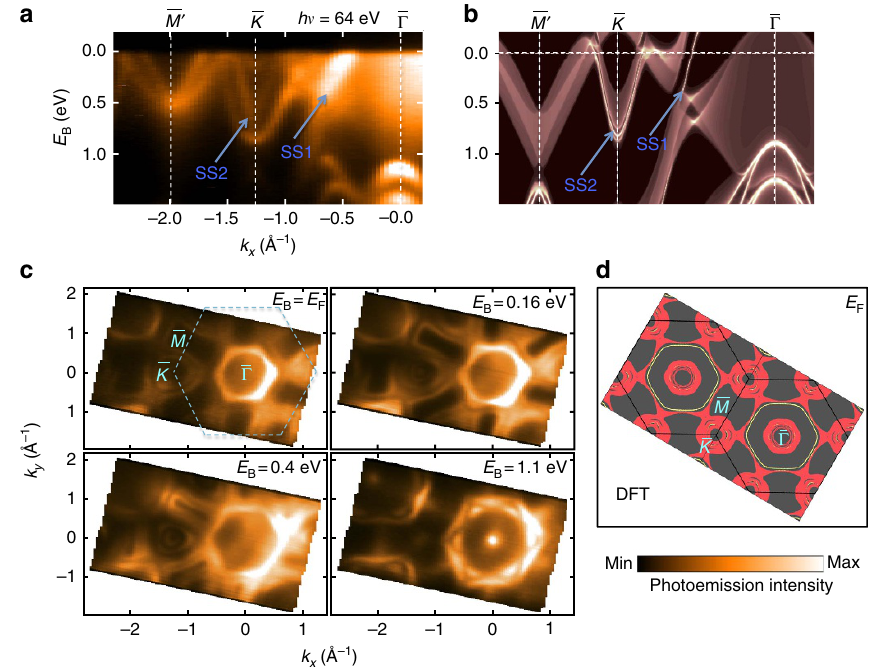
Figure 3 | APRES mapping and band calculation of PbTaSe 2 . ( a ) ARPES spectra taken along (cid:2) M (cid:2) (cid:2) K (cid:2) (cid:2) G with 64-eVphotons. ( b ) DFT-projected bulk bands and surface bands (bright white lines) of (001) surface with Pb termination. ( c ) ARPES isoenergy concours taken with 64-eV photons. ( d ) DFT Fermi surface contour of PbTaSe 2 (001) surface. The yellow lines indicate the surface states on Pb-terminated (001)